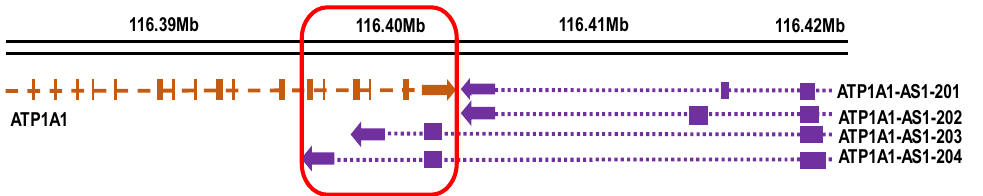
Figure 1. Schematic presentation of ATP1A1 and ATP1A1-AS1 gene. Sequence information was obtained from Ensembl (GRCh38). The vertical brown square indicates exons, and horizontal brown line indicates introns of the ATP1A1 gene. Purple square indicates exons, and purple dots indicates introns of ATP1A1-AS1 gene. The arrows indicate the transcriptional direction. The red square indicates the approximate overlapping sequences between ATP1A1 and ATP1A1-AS1 .